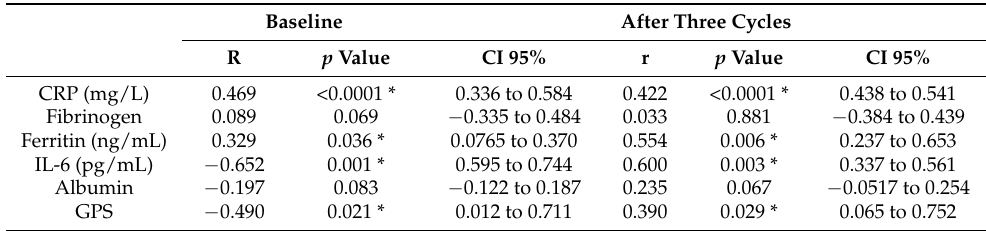
Table 3. Correlation between NLR and other laboratory parameters at baseline and after three cycles of chemotherapy.